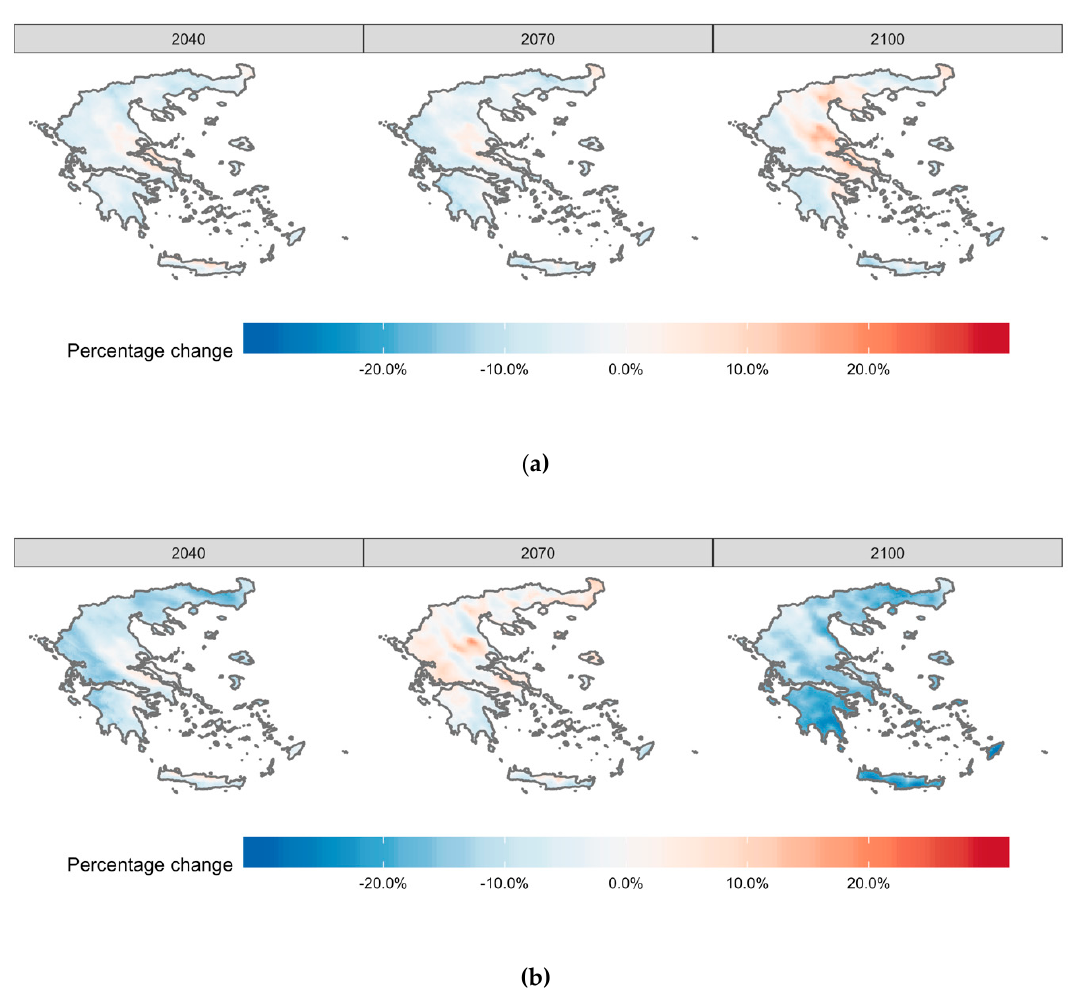
Figure 9. Projected percentage changes of rainfall erosivty, R , for the scenarios: ( a ) RCP4.5 and ( b ) RCP8.5 over the historical values.